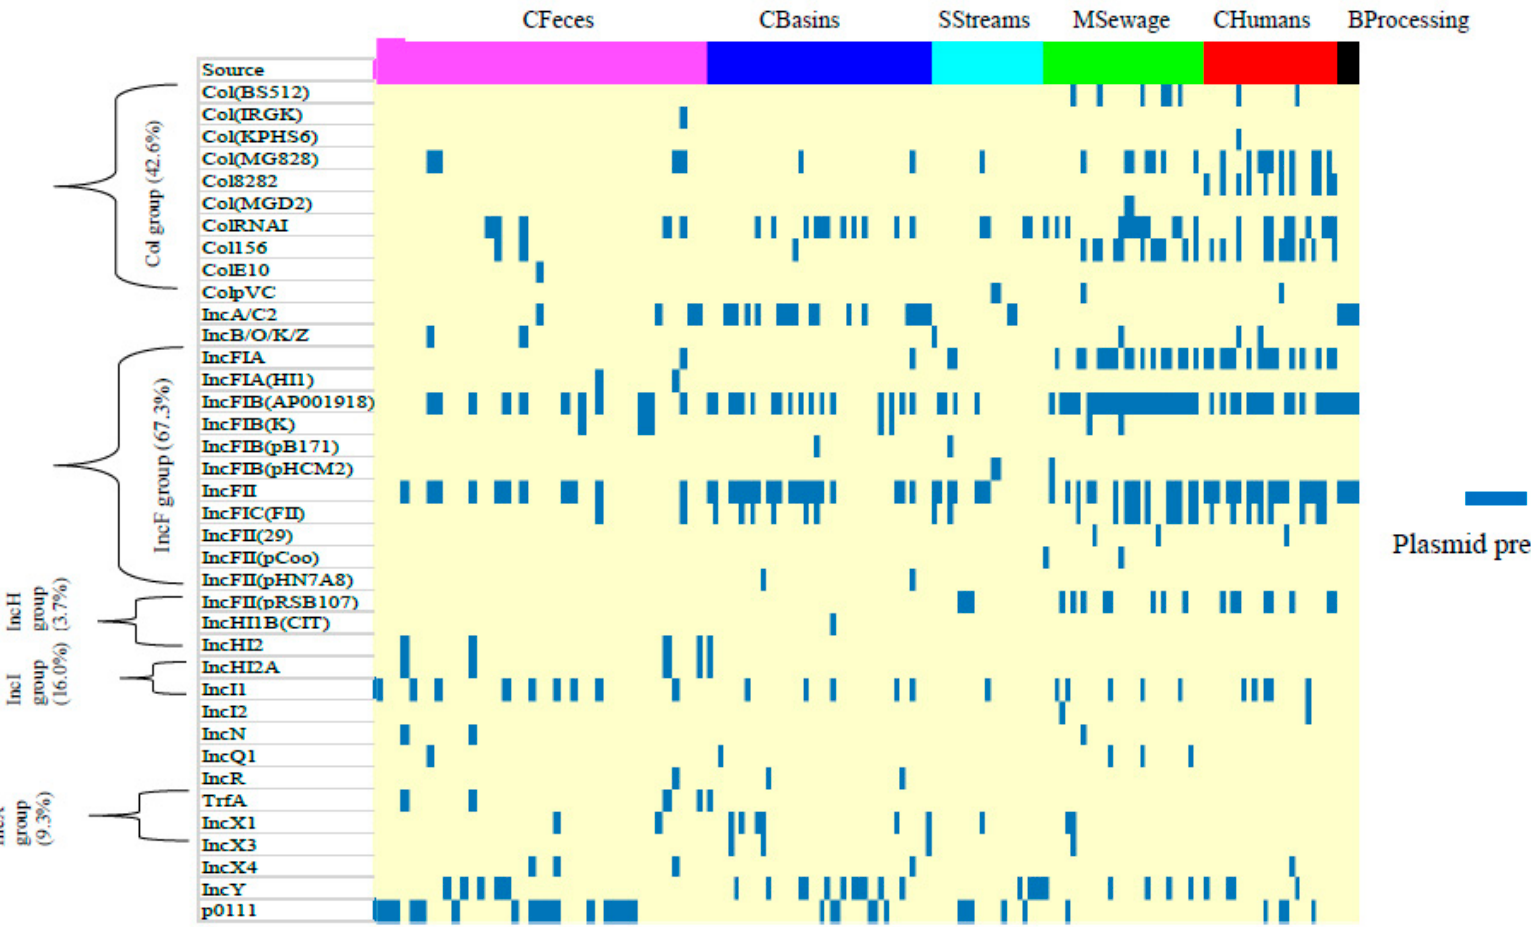
Figure 7. Prevalence of plasmid replicons per source of presumptive ESBL-producing E. coli from cattle feces, catch basins, surface streams, municipal sewage, humans, and beef processing along a One Health continuum.